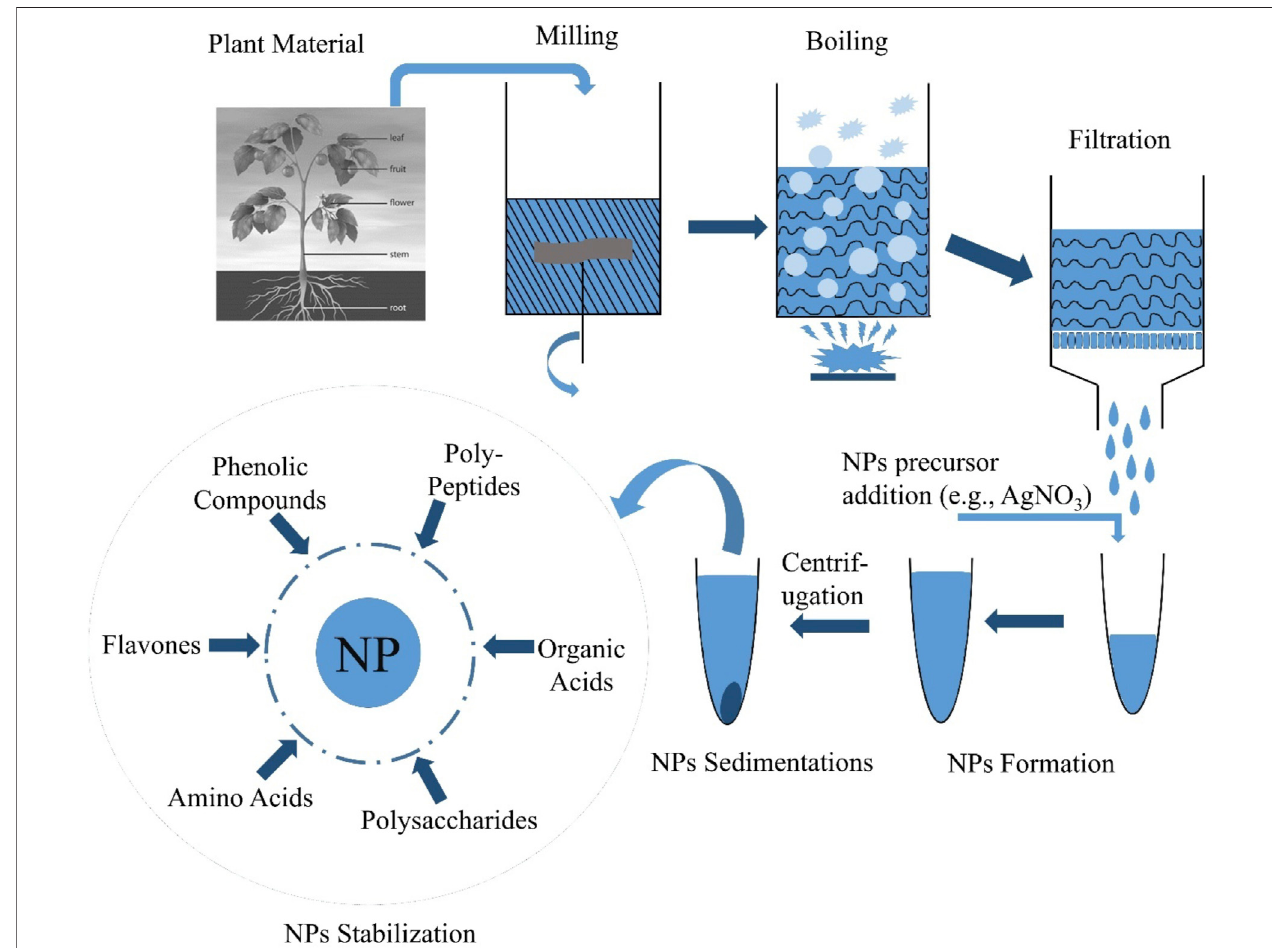
FIGURE 1 | Schematic representation of biosynthesis of nanoparticles from